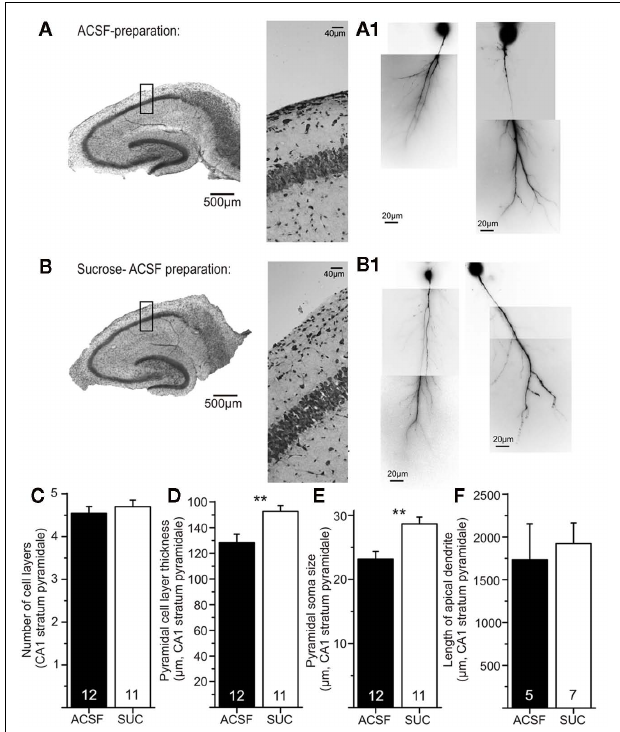
FIGURE 9 | Similar morphological properties of CA1 pyramidal neurons in both types of preparation. Hippocampal slices were prepared according to the two described procedures [ (A) : ACSF, (B) : sucrose] and subsequently processed for cresyl violet staining. Higher magnifications (20 × ) are shown in the middle panels. No obvious differences in the quality of slices are visible. Reconstructions of the apical dendrites of CA1 pyramidal cells with Alexa 488 Fluor are shown in (A1) for ACSF preparation and (B1) for sucrose prepared slices. No gross differences in dendritic length or branching are visible. Data are quantified in the lower panels: (C) Number of cell layers in stratum pyramidale in ACSF (black) and sucrose prepared slices (white bar) are similar ( p > 0.05). Sucrose preparation leads to an increase in thickness of stratum pyramidale (D) and an increased soma size of individual pyramidal cells (for explanation see text) compared to ACSF preparation [ (E) , p < 0.05]. (F) Total dendritic length of the apical dendrites is comparable for slices of both preparation